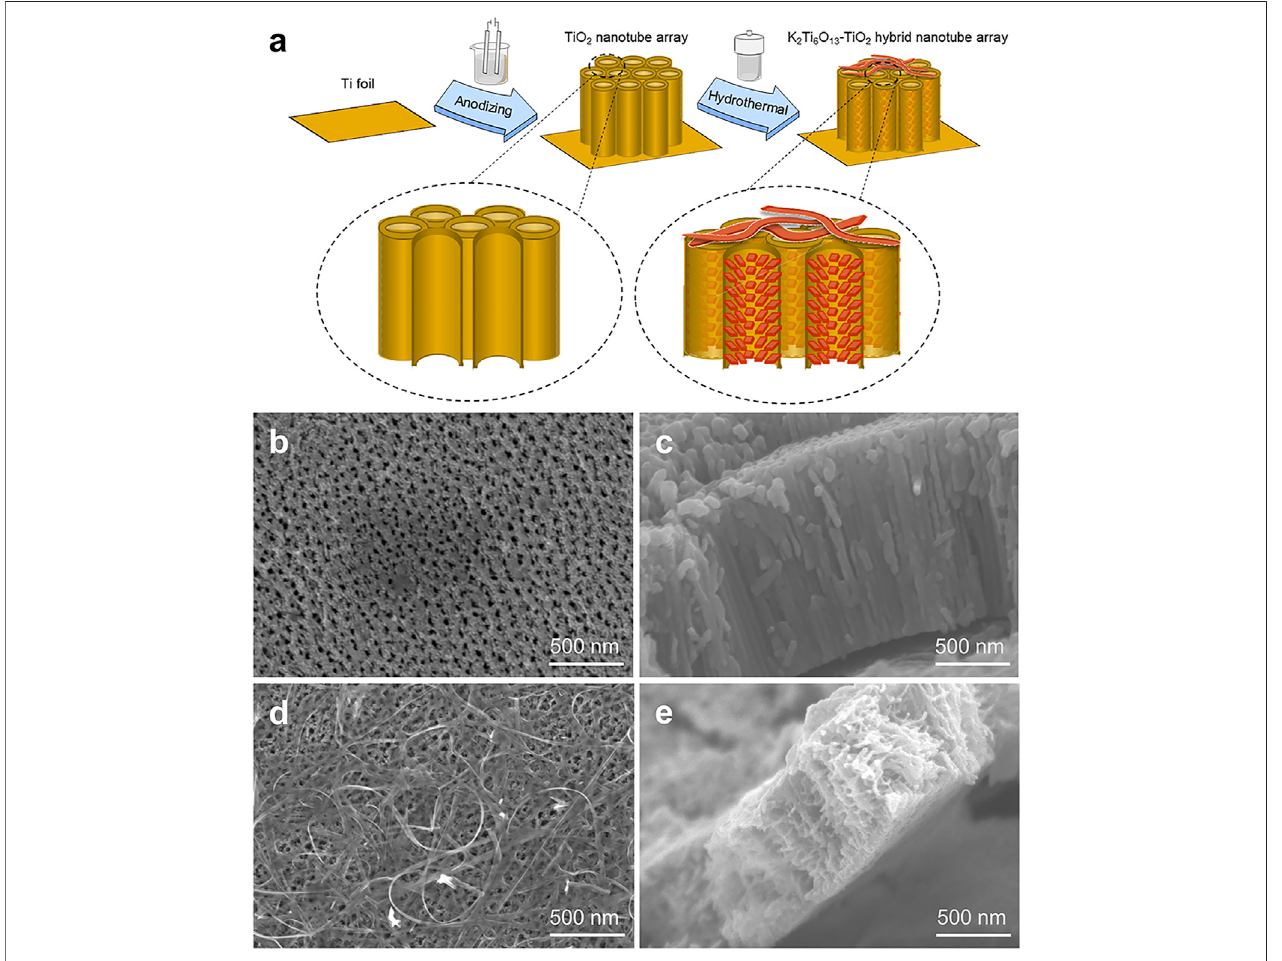
FIGURE 1 | Schematic illustration of TiO 2 and K 2 Ti 6 O 13 -TiO 2 hybrid nanotube arrays. (A) Schematic illustration of the K 2 Ti 6 O 13 -TiO 2 hybrid nanotube array preparationprocess.SEMimagesofthe (B) Top-down viewSEMimagesofTiO 2 nanotube array, (C) cross-sectionalSEMimageofTiO 2 nanotubearray, (D) Top-down view SEM images of K 2 Ti 6 O 13 -TiO 2 hybrid nanotube array, and (E) cross-sectional SEM image of K 2 Ti 6 O 13 -TiO 2 hybrid nanotube